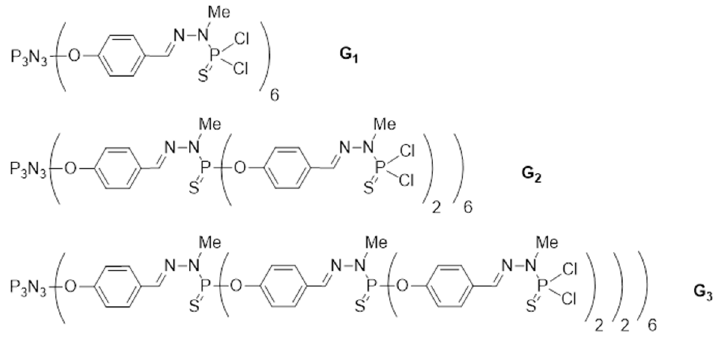
Figure 11. The schemes of G1, G2, G3 phosphorus dendrimers.